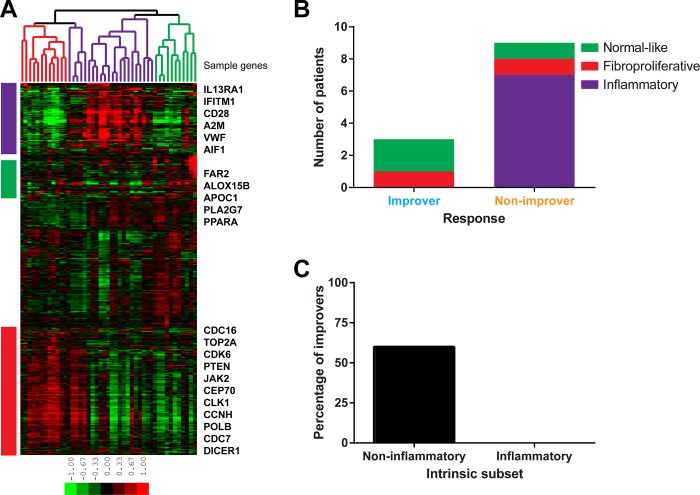
Intrinsic gene expression subset assignment and response status.(A) Intrinsic gene analysis. 3,207 probes (2,532 unique genes) at FDR<1.1% were used to organize samples into three gene expression-based clusters (intrinsic subsets). Sample color legend: red–fibroproliferative, purple–inflammatory, green–normal-like. (B) Distribution of patients according to their baseline intrinsic subsets and their response status. (C) Comparison between inflammatory and non-inflammatory (fibroproliferative and normal-like) patients in terms of the percentage of improvers.